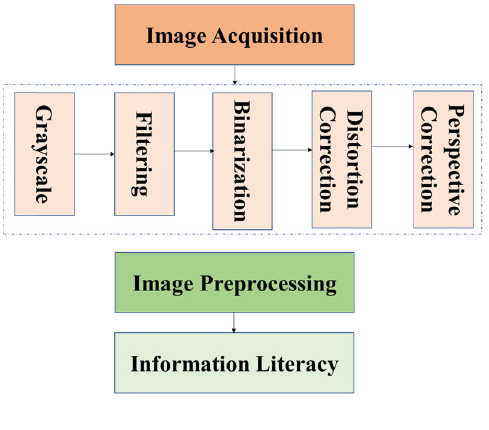
Figure 6: Test fl ow chart.